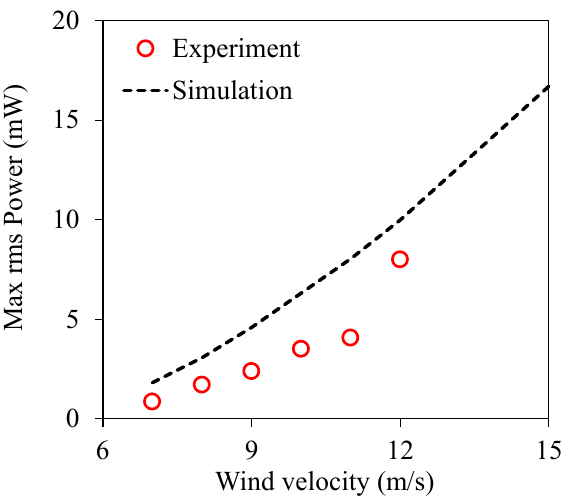
Figure 16. Variation of the maximum average (RMS) power with wind velocity under optimal load resistance.